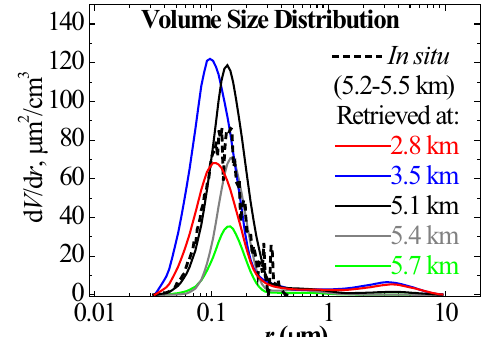
1. (cid:3) I. Veselovskii, et al., “Inversion of multiwavelength Raman lidar data for retrieval of bimodal aerosol size distribution”, (cid:36)(cid:83)(cid:83)(cid:79)(cid:17)(cid:3)(cid:50)(cid:83)(cid:87) . (cid:23)(cid:22) , 1180-1195 (2004). 2. (cid:3) D. Müller, et al., “Vertical profiles of microphysical particle properties derived from inversion with two-dimensional regularization of multiwavelength Raman lidar data: experiment", (cid:36)(cid:83)(cid:83)(cid:79)(cid:17)(cid:3) (cid:50)(cid:83)(cid:87)(cid:17) , Vol. (cid:24)(cid:19) , No 14, pp. 2069-2079 (2011). 3. (cid:3) P. Sawamura, et al., “HSRL-2 aerosol optical measurements and microphysical retrievals vs. airborne (cid:76)(cid:81)(cid:3) measurements during DISCOVER-AQ 2013: an intercomparison study”, (cid:36)(cid:38)(cid:51) , (cid:20)(cid:26) , pp. 7229–7243 (2017) . 4. (cid:3) D. Müller, et al., “Automated, unsupervised inversion of multiwavelength lidar data with TiARA: assessment of retrieval performance of microphysical parameters using simulated data”, (cid:36)(cid:83)(cid:83)(cid:79)(cid:17)(cid:3)(cid:50)(cid:83)(cid:87)(cid:17) , (cid:24)(cid:27) , No 6, in press (2019). 5. (cid:3) I. Veselovskii, et al, “Characterization of smoke/dust episode over West Africa: comparison of MERRA-2 modeling with multiwavelength Mie-Raman lidar observations”, 6. (cid:3) M. Tesche et al., Vertically Resolved Separation of Dust and Smoke Over Cape Verde Using Multiwavelength Raman And Polarization Lidars During Saharan Mineral Dust Experiment 2008, (cid:45)(cid:42)(cid:53)(cid:15) (cid:20)(cid:20)(cid:23) , D13202, 2009. 7. (cid:3) A. Kolgotin, et al., “Improved identification of the solution space of aerosol microphysical properties derived from the inversion of profiles of lidar optical data, part 3: case studies”,